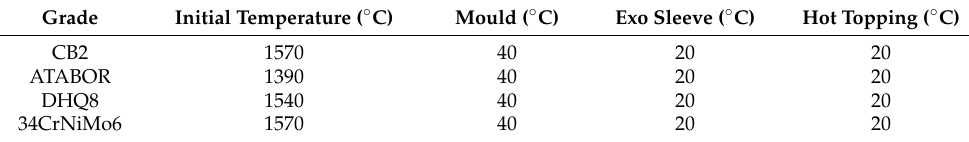
Table 2. Temperatures of the melt and the teeming set components before the filling.